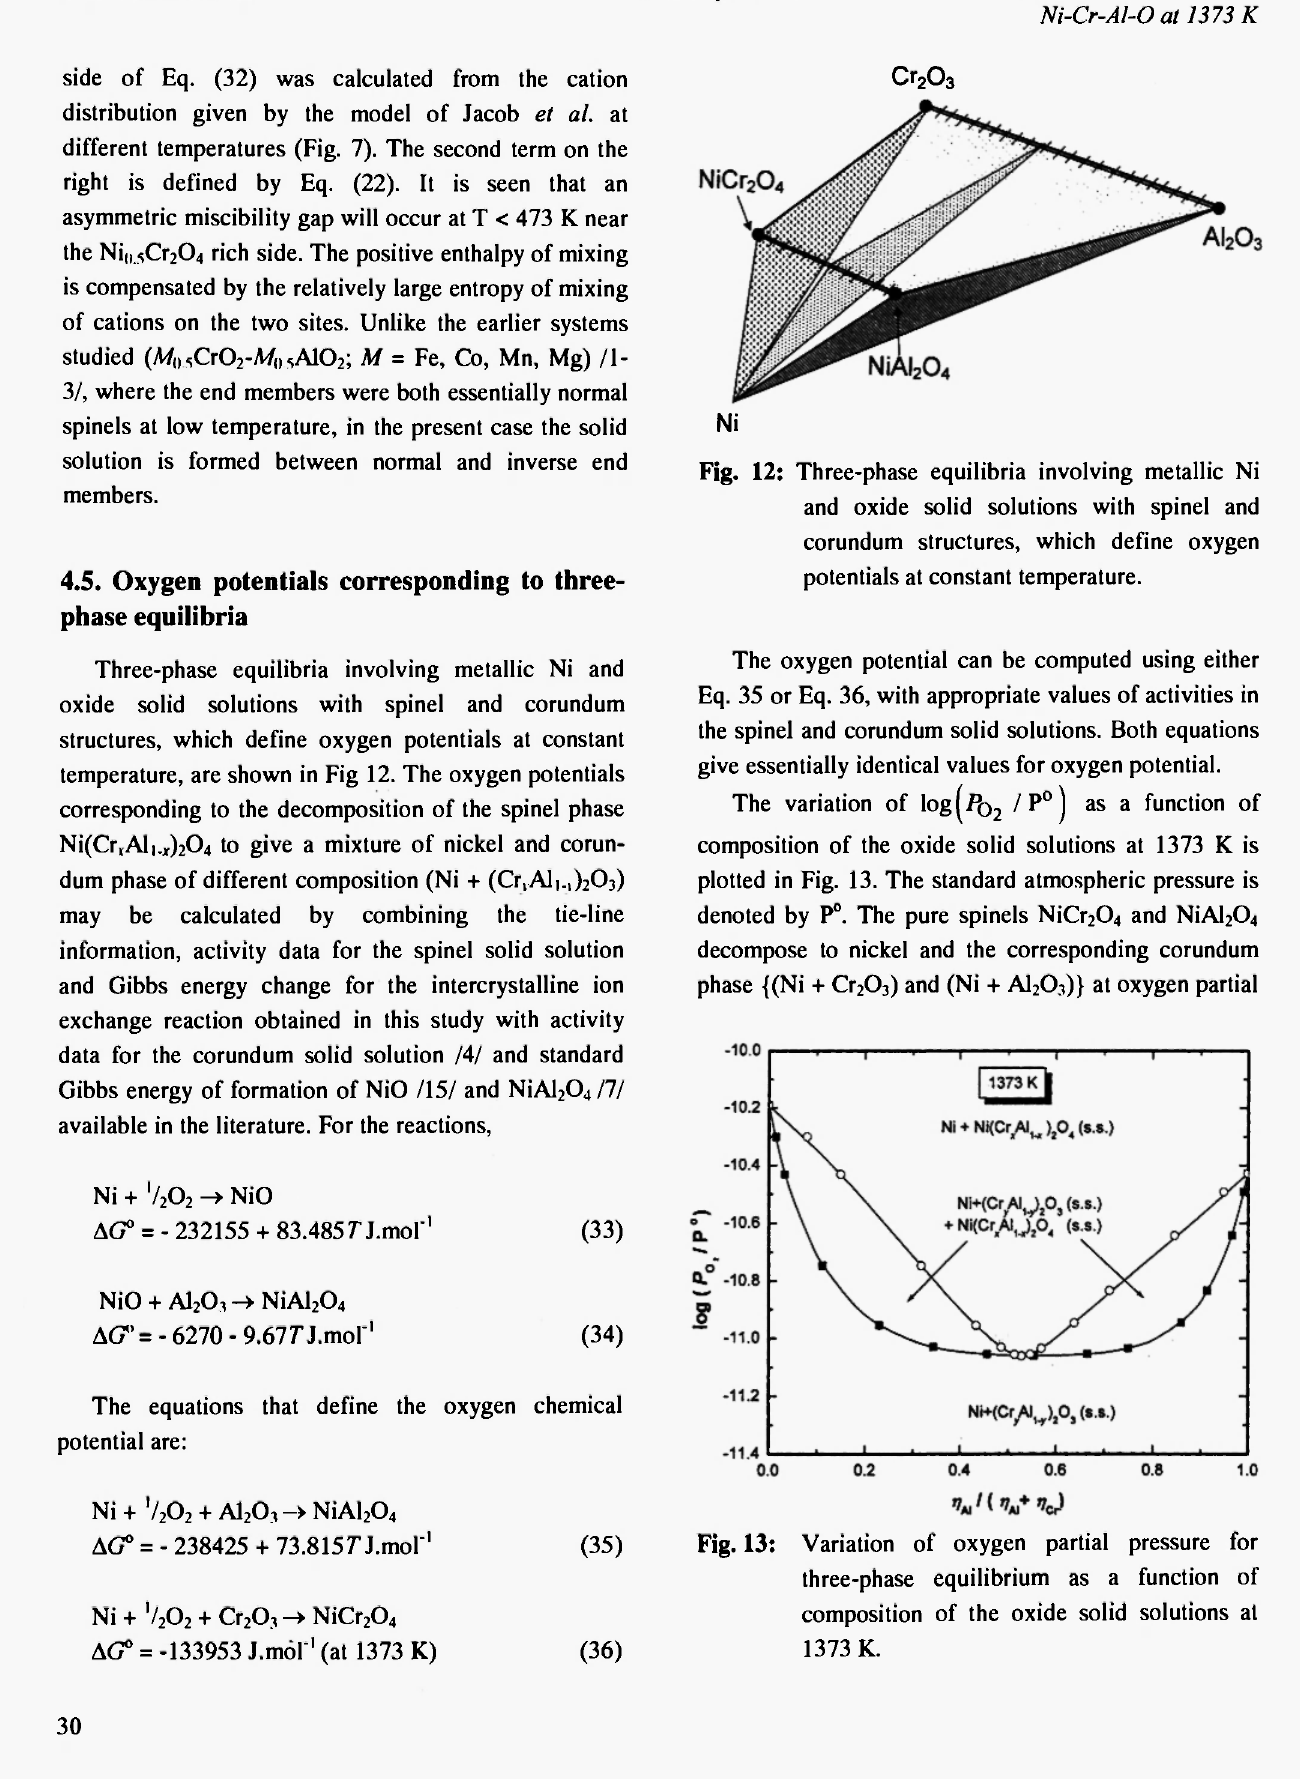
Fig. 13: Variation of oxygen partial pressure for three-phase equilibrium as a function of composition of the oxide solid solutions al 1373